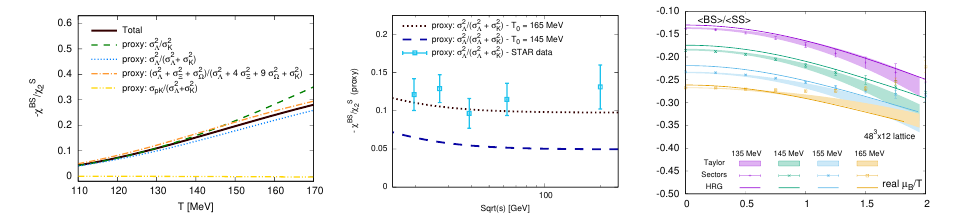
Figure 6. (Ref. [32]) Left: Calculations for di ff erent combinations of praticle number cumulants (proxis) that could be measurable in heavy ion collision expermients and the total of sible in lattice QCD calculations with the Hadron Resonance Gas (HRG) model. Middle: Comparison / ( σ 2 + σ 2 of the proxy σ 2 ) for two temperatures in the HRG model and experimental results from Λ Λ K Ref. [33] Right: Comparison between the Taylor (see equation (1)) and the sector (see equation (2)) χ BS 11 method for on an 48 3 12 lattice, as well as results from the HRG model. χ S 2 − ×